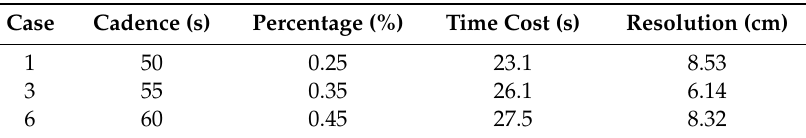
Table 10. Resolution in optimal cases with one neuron and delay